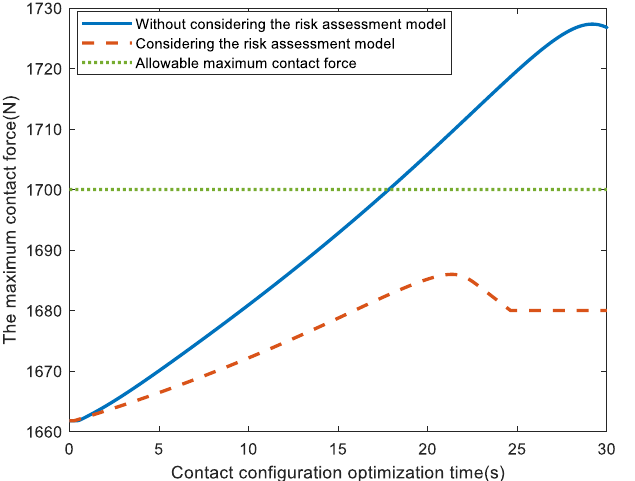
Figure 15. The change of the maximum contact force with and without considering the risk assess- ment model.